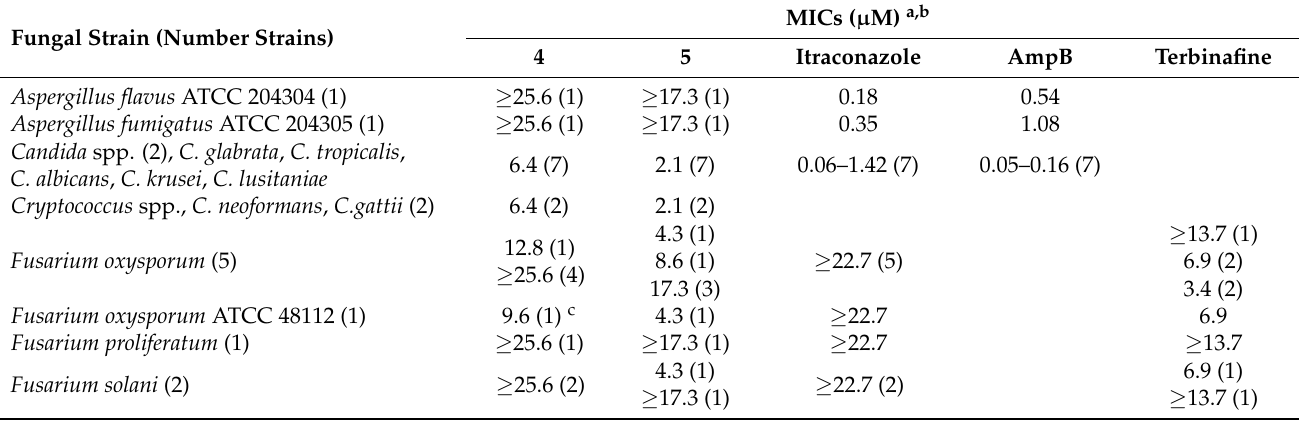
Table 1. Antifungal activity (MICs, μ M) of perylene bisimide derivatives and controls against different fungal strains.